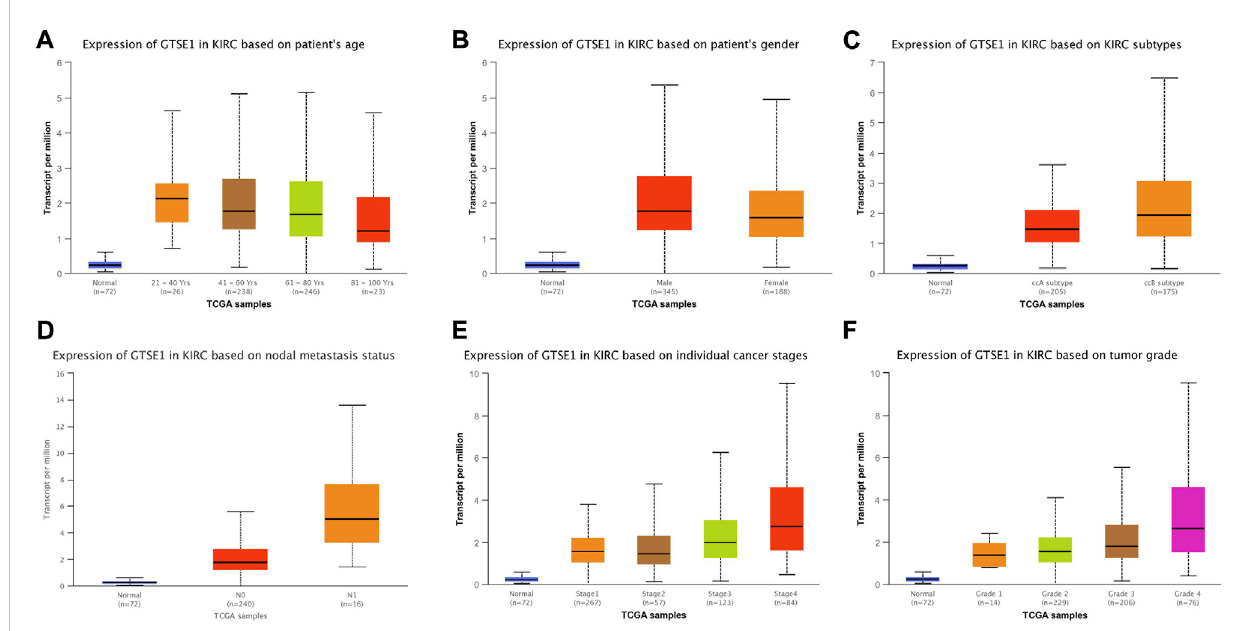
FIGURE 2 GTSE1 expression in subgroups of different clinical characteristics. Box plots showing the relative mRNA expression of GTSE1 in different groups of ccRCC patients: (A) patient age (B) , patient gender (C) ccRCC subtypes, (D) nodal metastasis status, (E) individual cancer stages, and (F) tumor